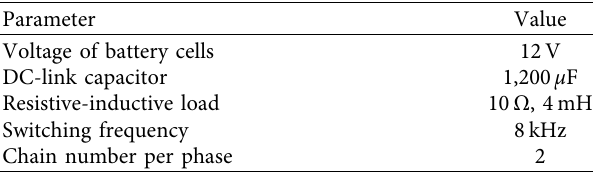
Table 1: Parameter settings for